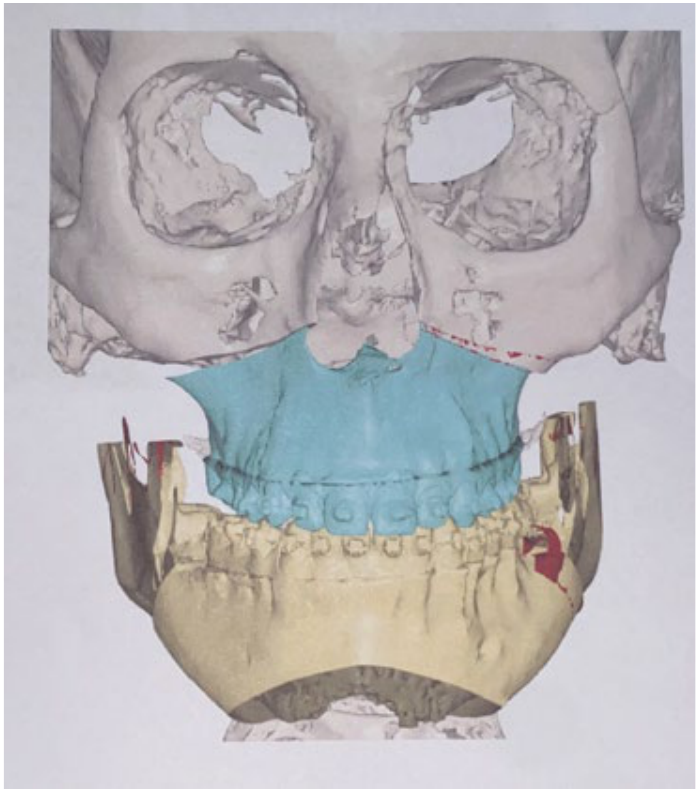
Figure 12. Virtual 3D model and a surgical guide.